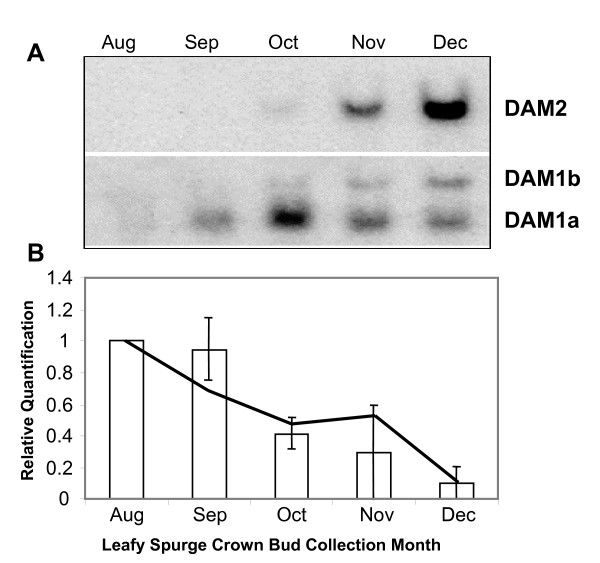
Comparison of DAM gene and FT expression through dormancy transitions. A) northern blot analysis of DAM1 and DAM2 expression over a representative seasonal time course (2004) in leafy spurge. B) Bars show relative RT-PCR analysis of FT expression over 3 years with the line showing expression during the 2004 year. Error bars represent standard deviation of yearly expression pattern.